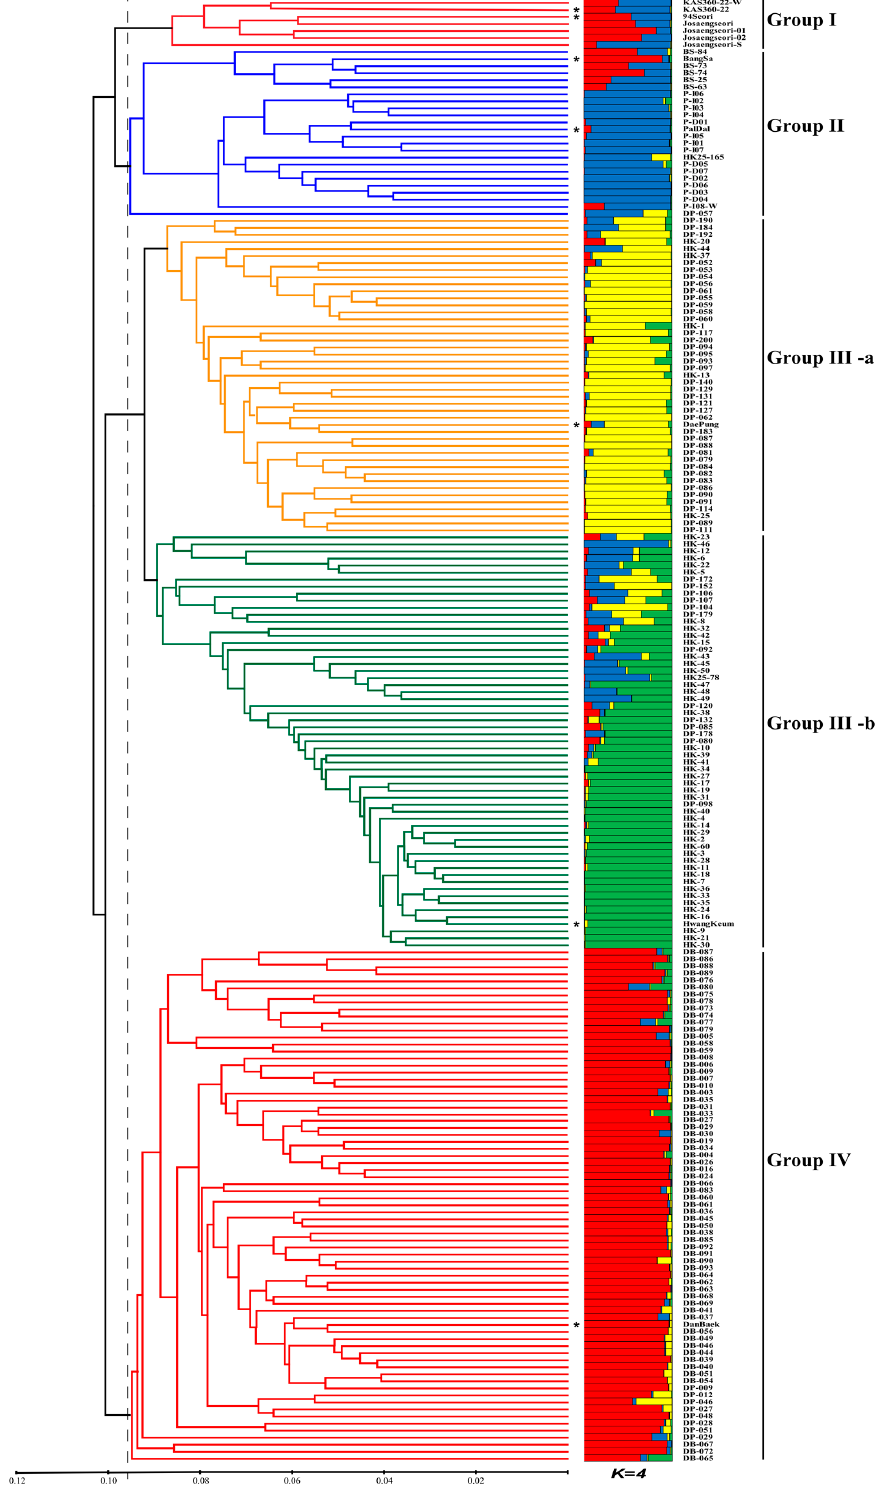
Figure 4. Dendrogram revealed by unweighted pair group method with arithmetic mean (UPGMA) cluster analysis and the population structure of 208 soybean MDP lines based on TRAP markers. * Indicated original cultivars.